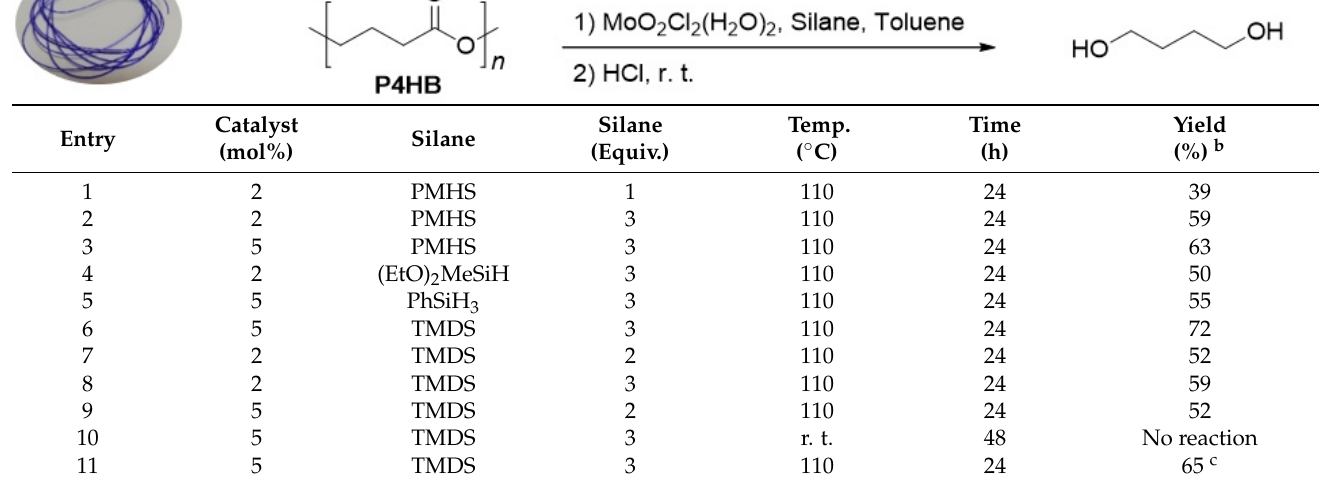
Table 1. Reductive depolymerization of P4HB with the catalytic system MoO 2 Cl 2 (H 2 O) 2 /Silane a .